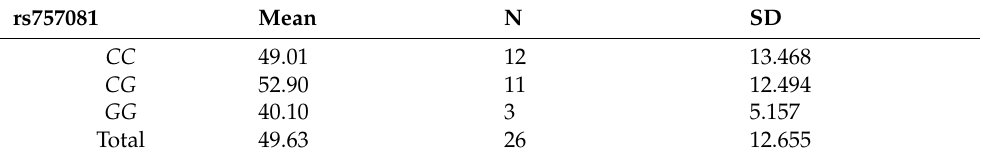
Table 5. Mean plasma nesfatin-1 levels (ng/mL) based on NUCB2 polymorphism.